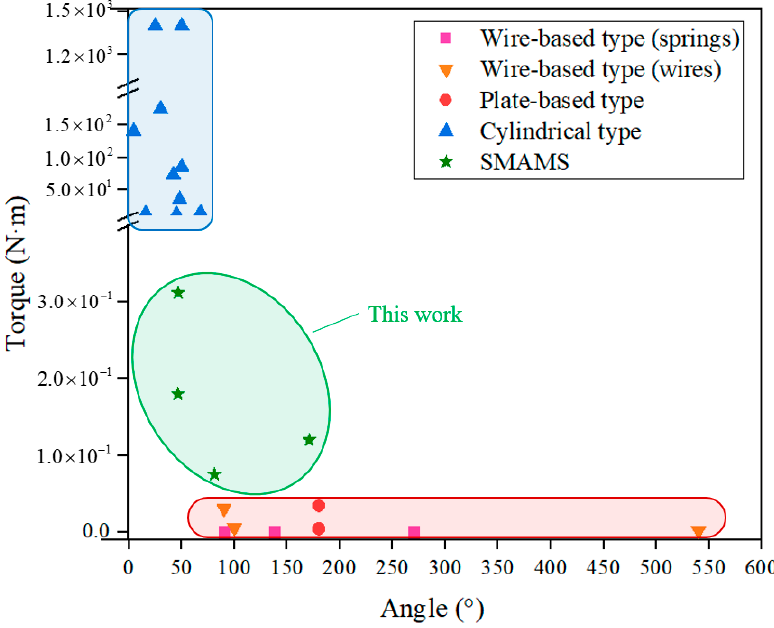
Figure 14. Comparisons between the SMAMSs and other types of SMA rotary actuators, ie.